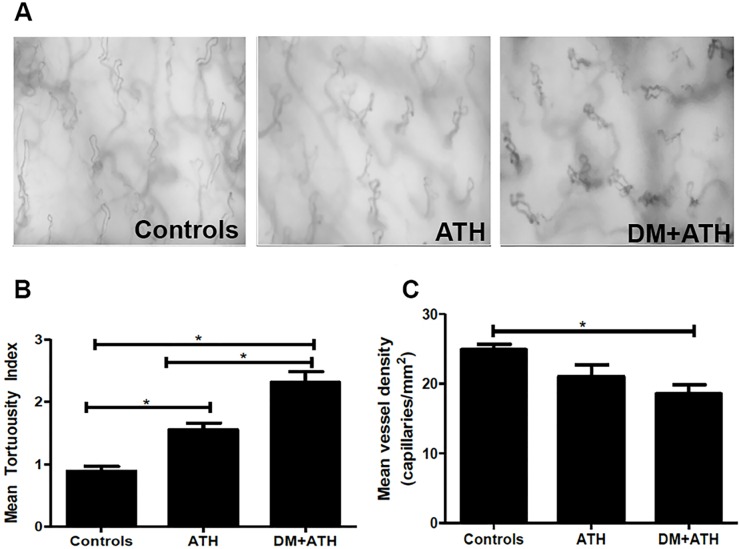
Early atherogenic DM leads to increased capillary tortuosity.A. Sidestream darkfield images of the oral mucosa visualizing the microvascular capillaries of a representative pig in the Controls, ATH and DM+ATH group. B. Mean tortuosity index of microvascular capillaries in the Controls (n = 7), ATH (n = 5) and DM+ATH pigs (n = 5). C. Mean vessel density (capillaries/mm2) in Controls (n = 7), ATH (n = 5) and DM+ATH (n = 5) pigs. Data shown are mean±SEM. *P<0.05 compared to Controls or ATH pigs. Mean vessel density (capillaries/mm2) was calculated by evaluation of number of vessels per selected microcirculatory image. Subsequently, tortuosity of capillary loops was assessed according to a validated scoring system (0: no twists to 4: four or more twists) and the average of assessed capillary tortuosity was used to calculate mean tortuosity index per patient.